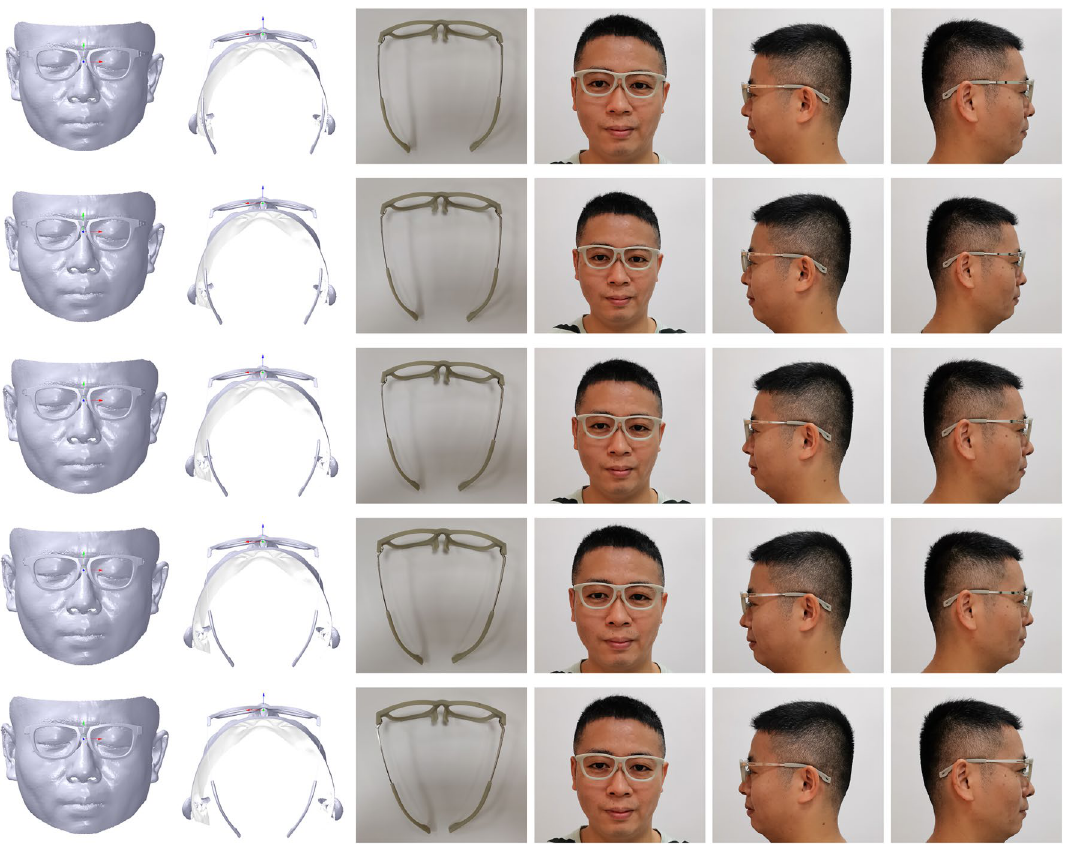
Figure 22. Try-on results of pile head rotation. From left to right: the front view, the vertical view, the printed glasses, the front view, the left view, the right view. From top to bottom: β with 3°, 6°, 9°, 12° and 15°.